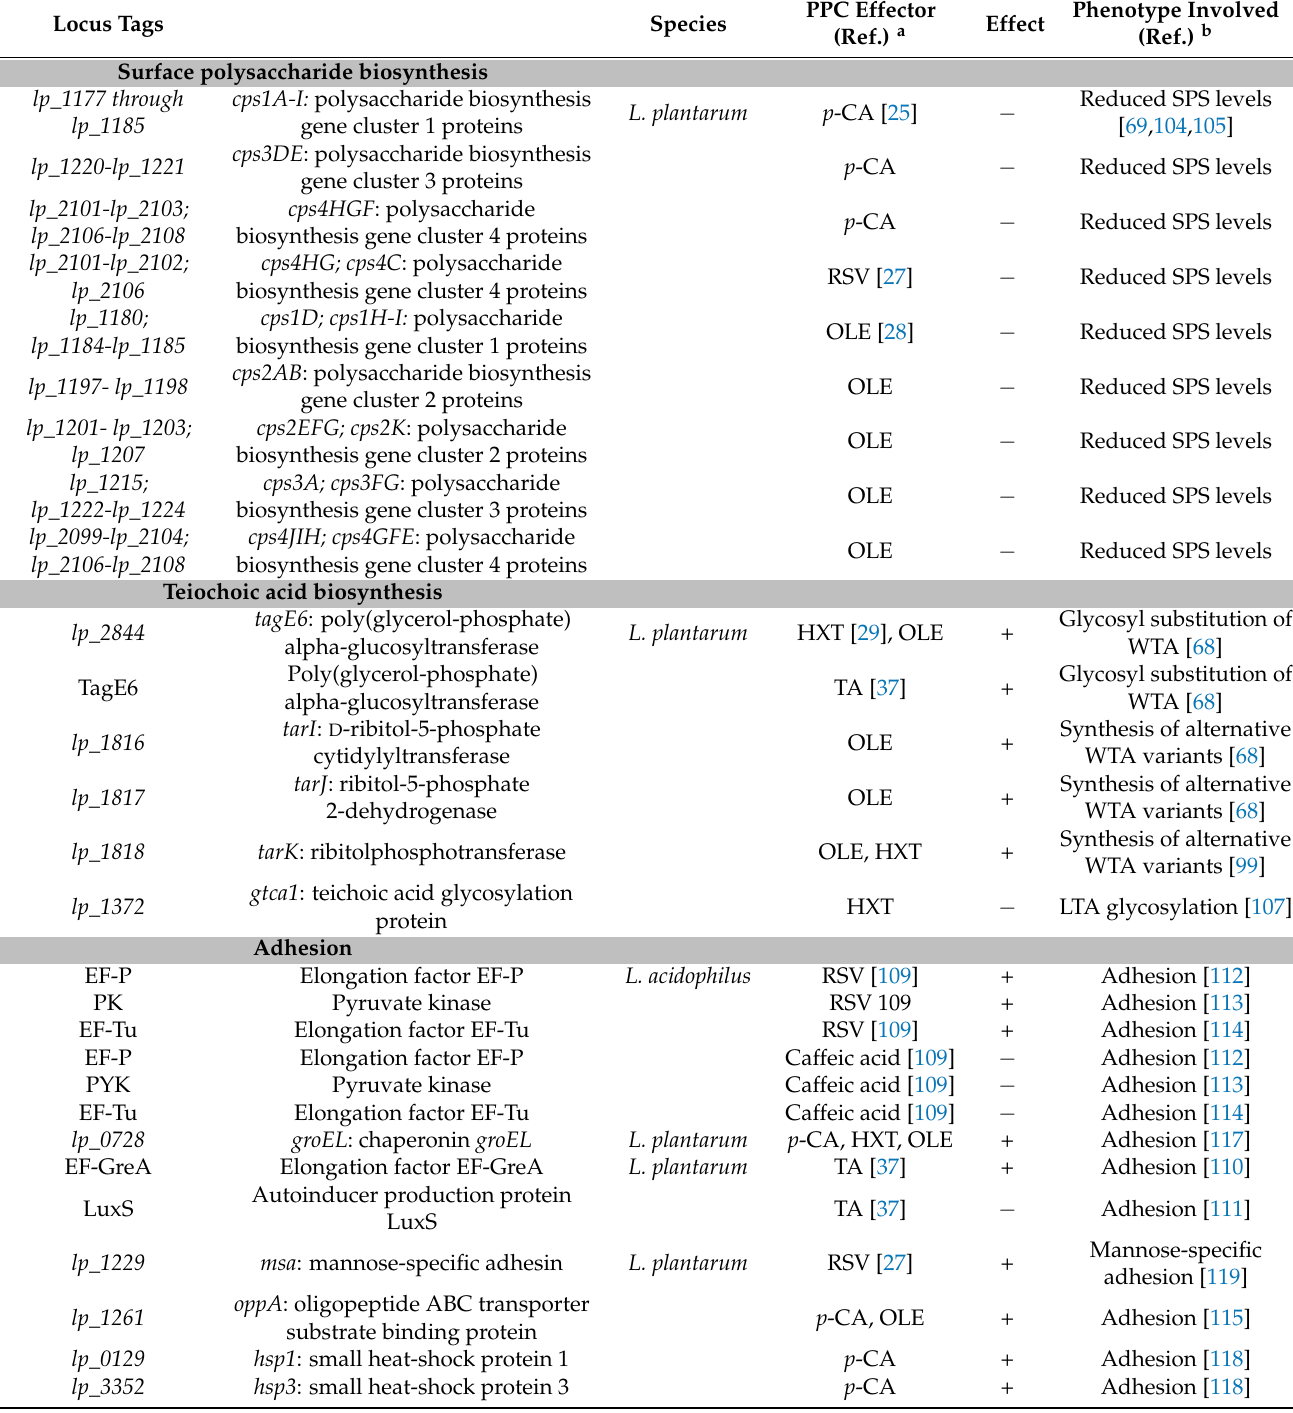
Table 4. Genes and proteins of Lactobacillus involved in the interaction with host cells that are differentially expressed by plant phenolic